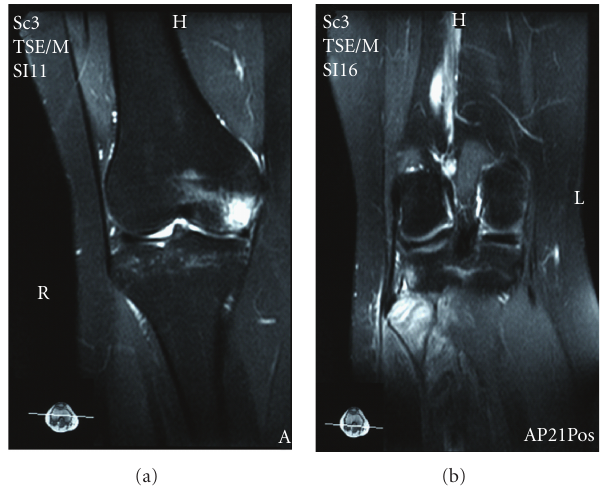
Figure 3: MRI of the right knee showing medial condyle bruise (a) as well as edema of the head of fibula due to fracture